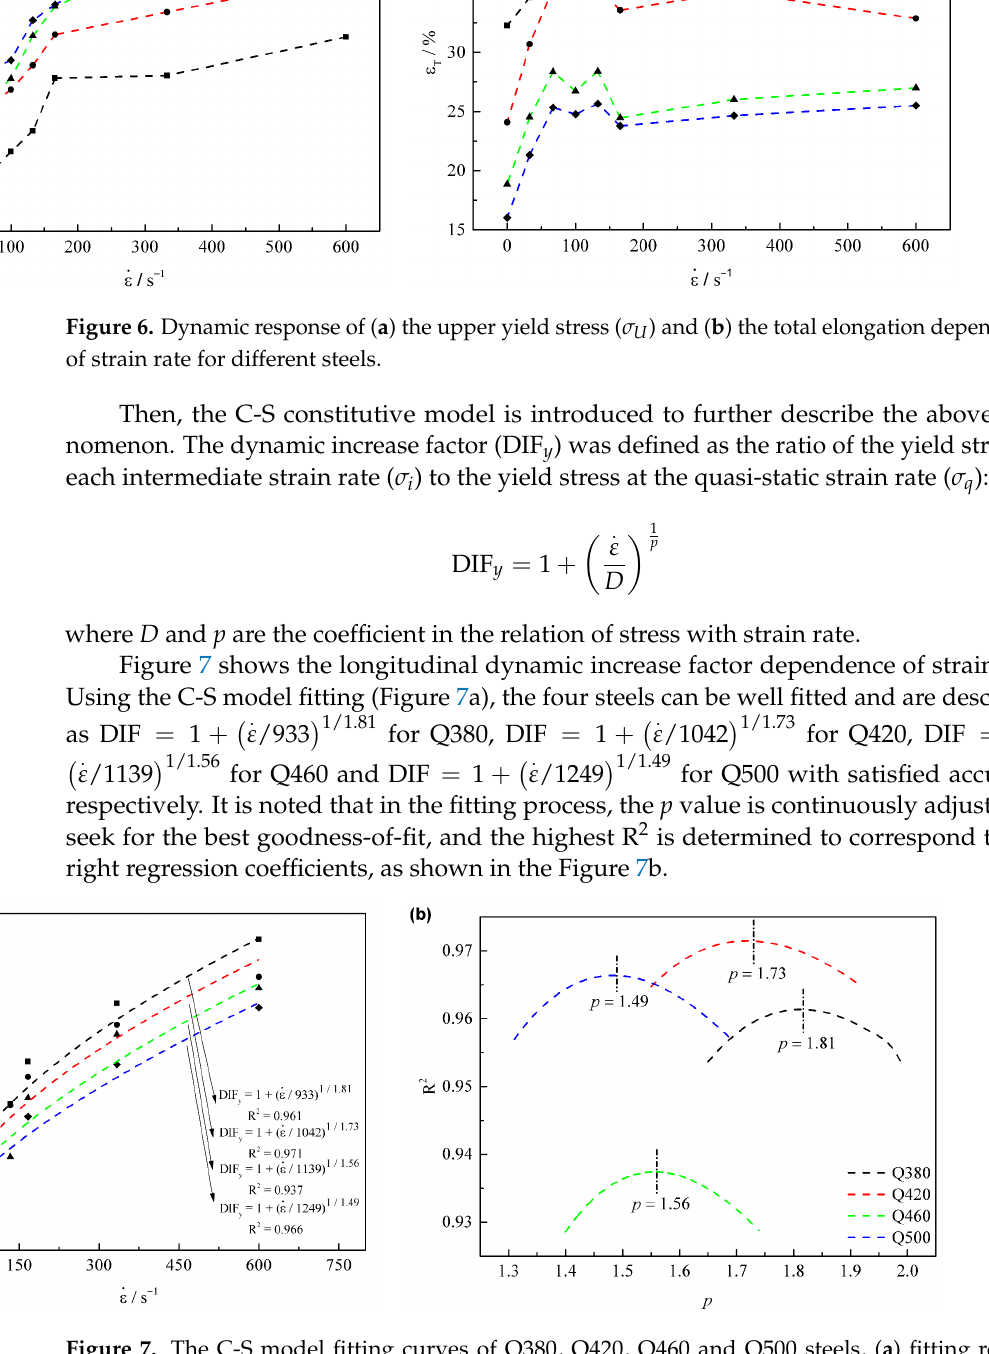
Figure 7. The C-S model fitting curves of Q380, Q420, Q460 and Q500 steels, ( a ) fitting results, ( b ) determination method for the p solution.